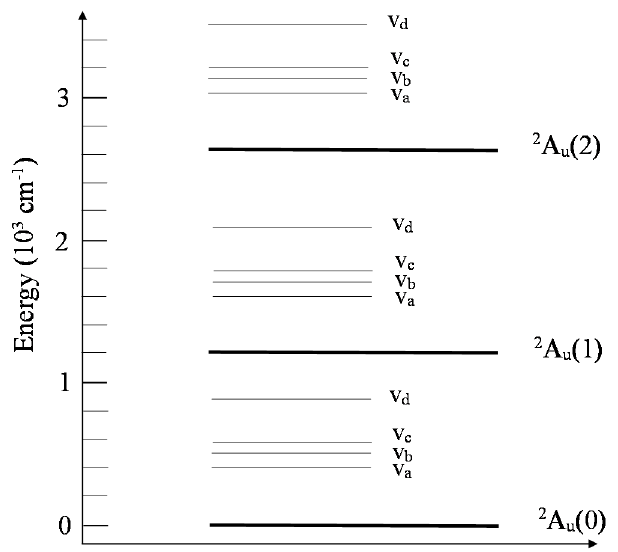
Figure 6. Energies of the sub-levels of the ground state of Ti:Al 2 O 3 (to scale). The three 2 A u electronic levels are labeled 0, 1, 2 in order of increasing energy, following Ref. [22]. The four vibrational sub-levels labeled a, b, c, d correspond to four allowed modes for π -polarization [21]. Only singly excited vibrational sub-levels are shown for each mode in association with each electronic state as only the first vibrational level is significantly populated at room temperature.